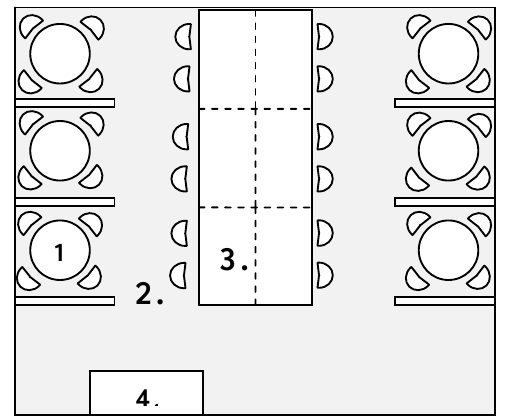
Figure 1. Classroom geometry of the design studio for the Freshman Engineering Design Course, using the Pure PBL pedagogical model, containing (1.) workspaces with round tables, chairs, bulletin boards and white board walls, (2.) partial partition walls, (3.) partitioned work- benches, and (4.) and instructor’s